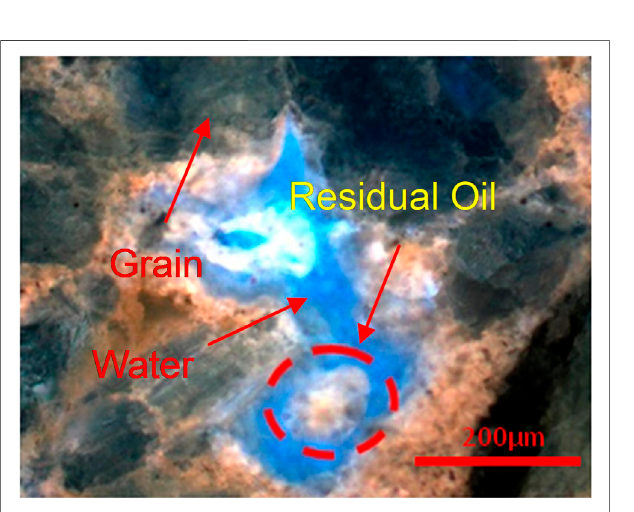
FIGURE 10 | Distribution of petroleum-clay mixed residual